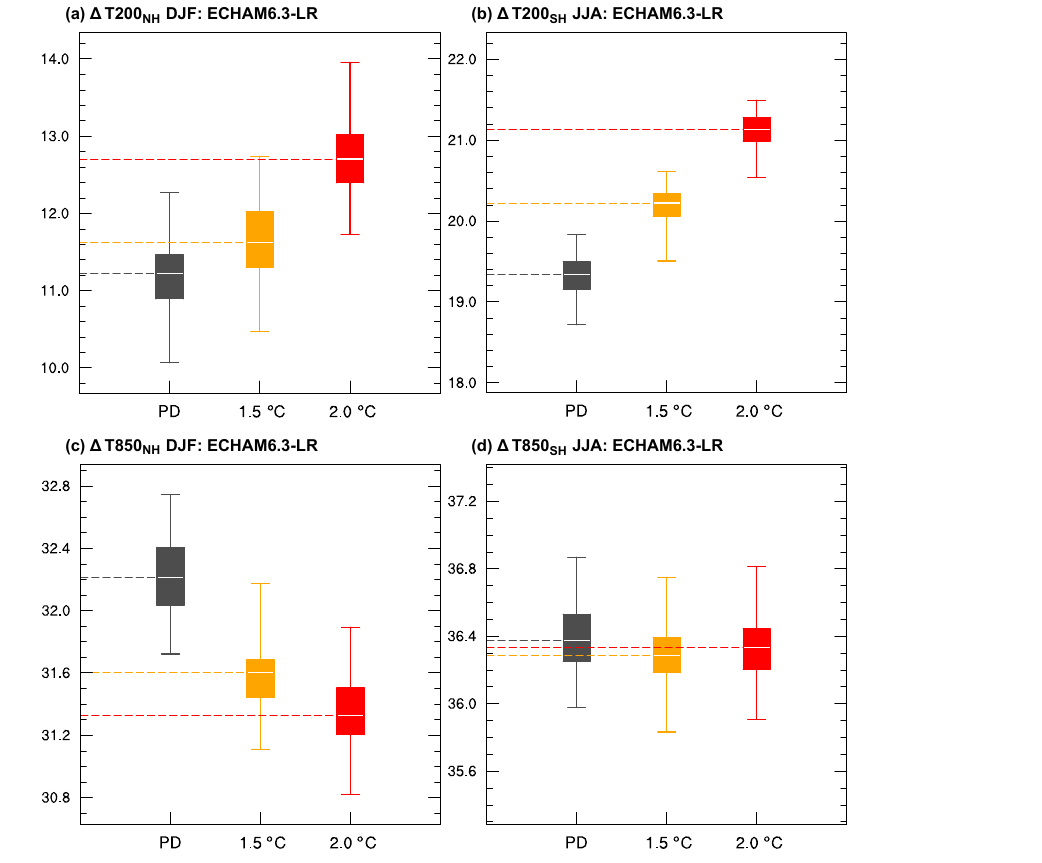
Figure 11. Changes in upper- and lower-level equator-to-pole temperature gradients (following Harvey et al., 2014) in the PD (grey), 1.5 ◦ C (orange), and 2.0 ◦ C (red) experiments in the ECHAM6.3-LR ensemble. The Northern Hemisphere temperature gradient is defined as the difference between the area-averaged temperature in the 30 ◦ S–30 ◦ N band and the region poleward of 60 ◦ N, taken at 850hPa ( (cid:49)T 850 NH ) and 200hPa ( (cid:49)T 200 NH ). The Southern Hemisphere gradient is defined as the difference between the 30 ◦ S–30 ◦ N band and the region poleward of 60 ◦ S, taken at 850hPa ( (cid:49)T 850 SH ) and 200hPa ( (cid:49)T 200 SH ). The white horizontal line in the boxes indicates the median, the boxes indicate the interquartile range, and the whiskers indicate the ECHAM6.3-LR ensemble